Question: Based on the figure, does the quantity rise or fall?
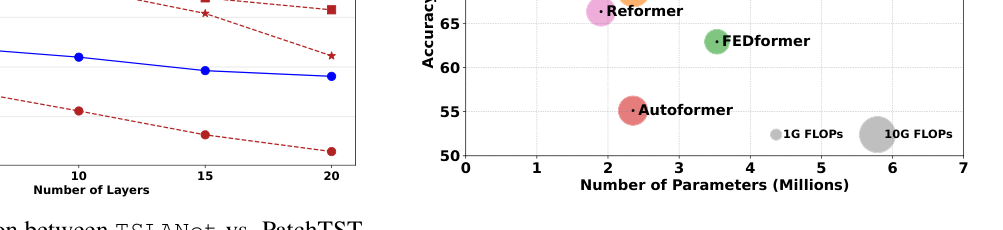
Answer: increasing